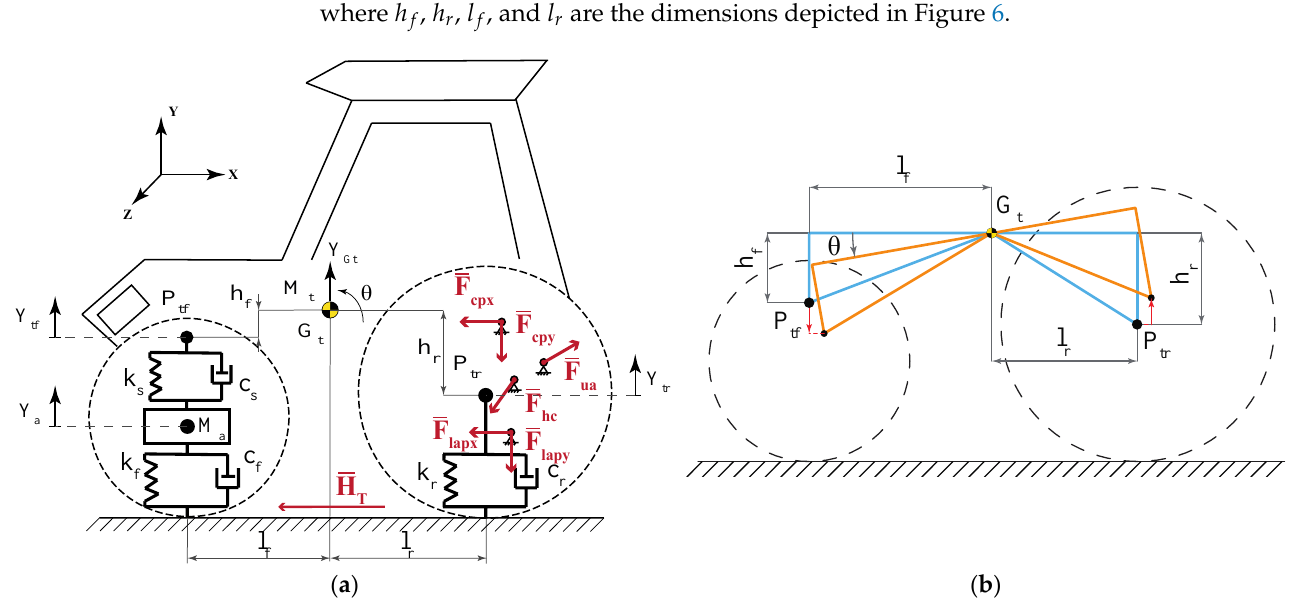
Figure 5. TPH model. ( a ) Lower arms; ( b ) lift arms.